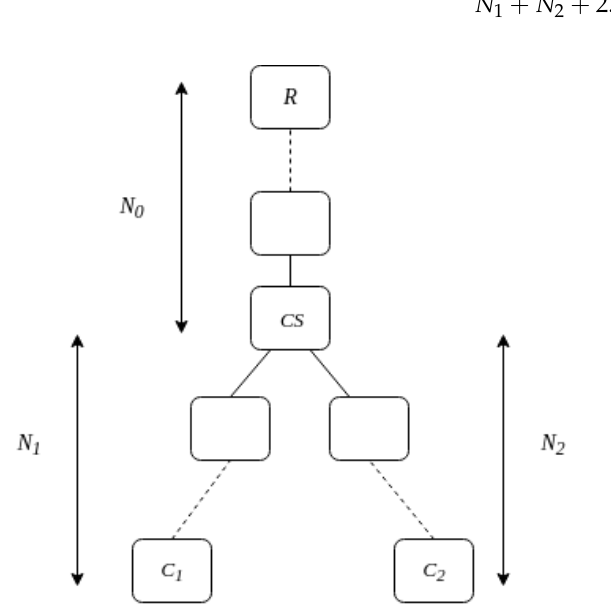
Figure 3. Wu and Palmer ontology